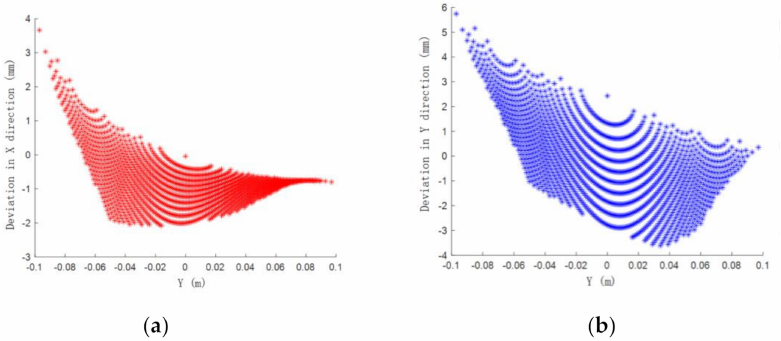
Figure 11. The deviation of the tip position caused by the cable length error seen from Y direction: ( a ) The deviation in X direction; ( b ) the deviation in Y direction.